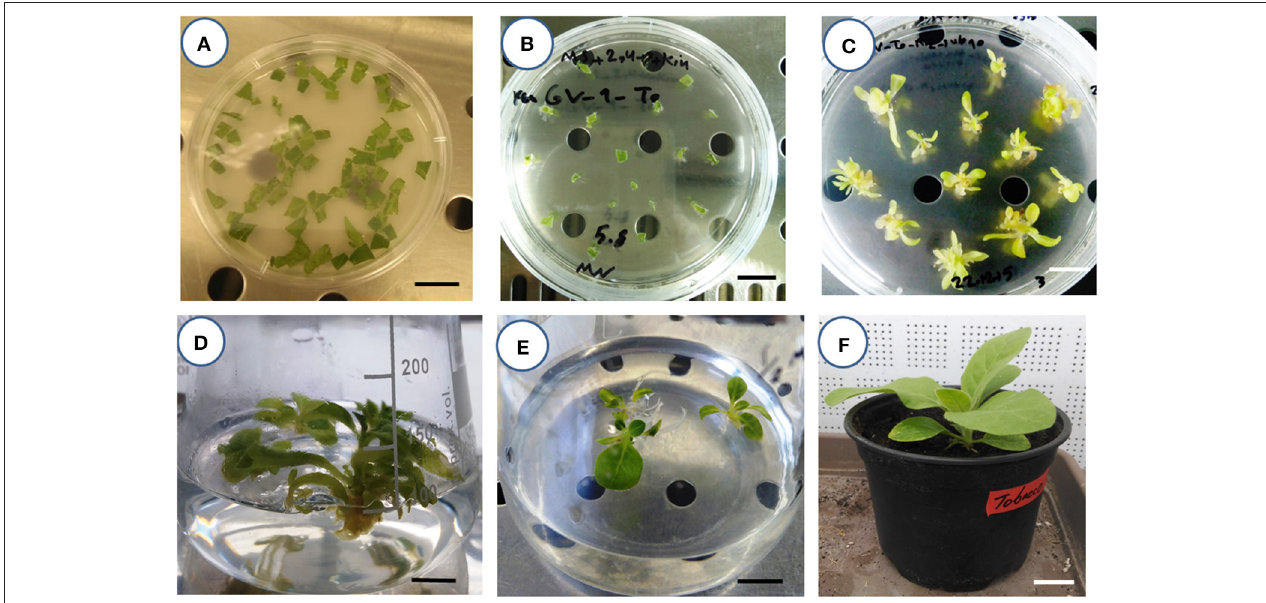
FIGURE 1 | Steps for creating putative transgenic tobacco plants. (A) The inoculation of leaf square explants in Agrobacterium suspension (bar = 2cm). (B) The establishment of Agrobacterium -inoculated explants in an agar-solidified selective regeneration medium (bar = 2cm). (C) The emergence of direct regenerated shoots in the selective regeneration medium (bar = 2cm). (D) The rooting of putative transgenic shoots in the PGR-free MS medium containing kanamycin and cefotaxime antibiotics (bar = 2cm). (E) The elongation of the rooted putative transgenic seedling of tobacco in the PGR-free MS medium containing kanamycin and cefotaxime antibiotics (bar = 2cm). (F) The acclimatization of the putative transgenic tobacco plant under greenhouse conditions (bar =